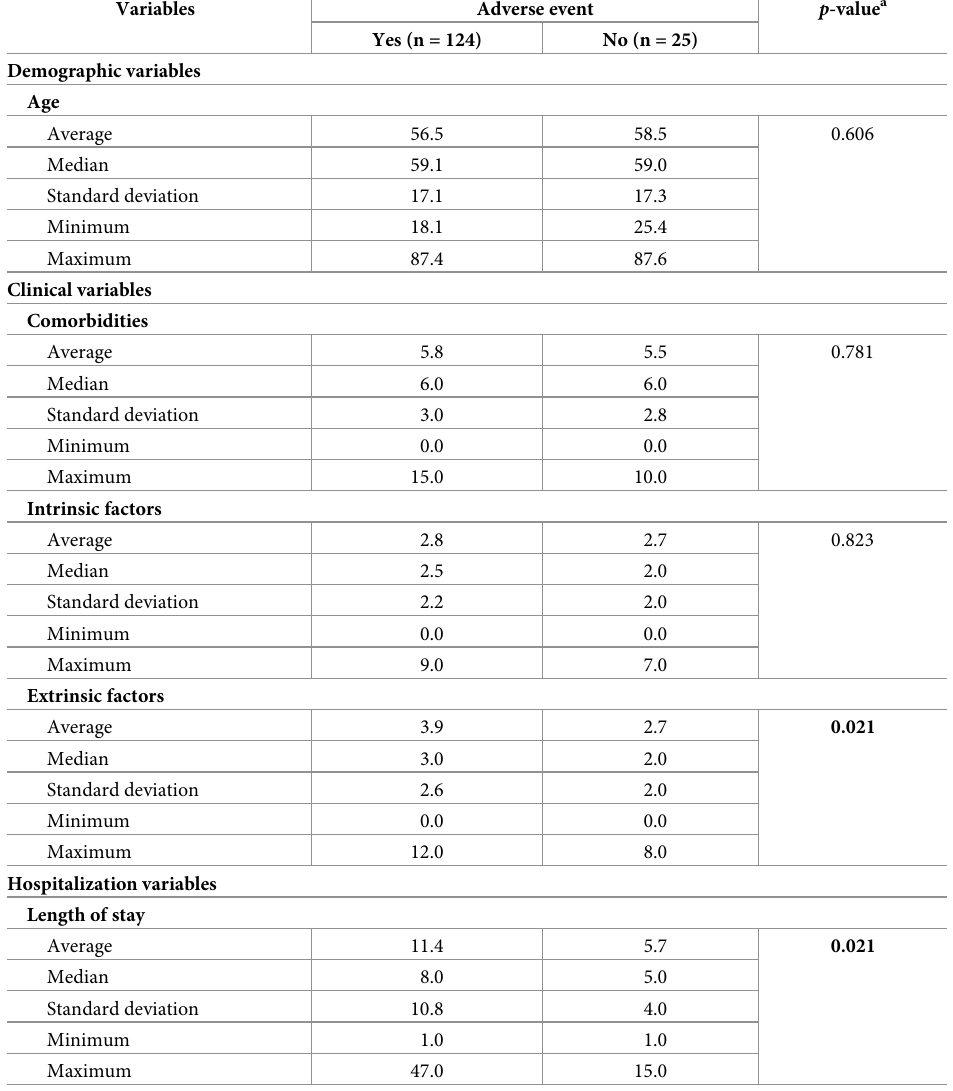
Table 2. Demographic, clinical and hospitalization variables of the groups of patients with and without adverse